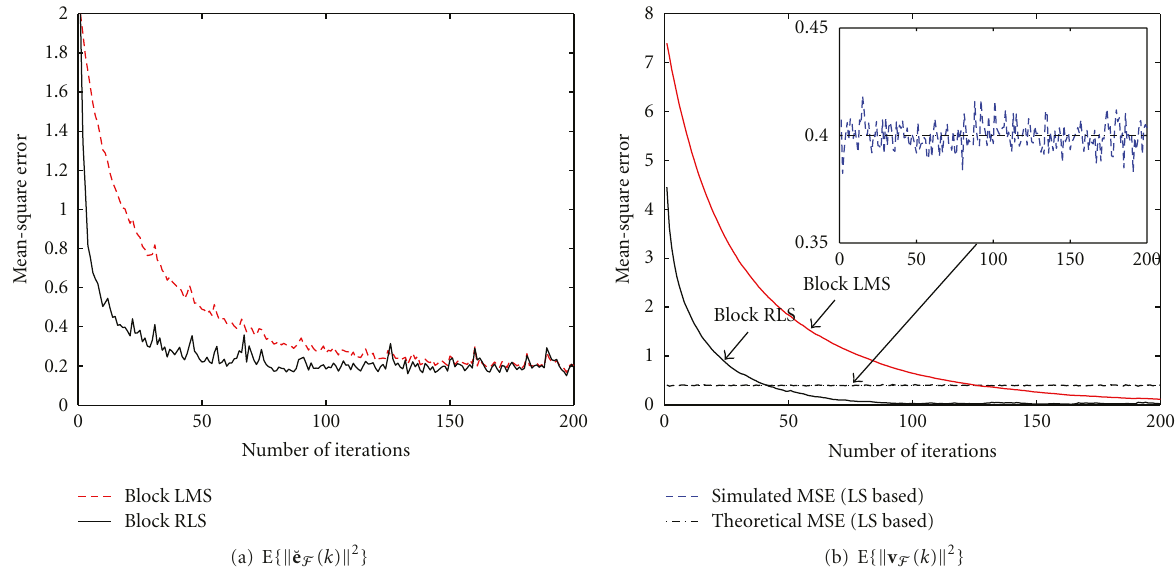
Figure 7: Learning curves of the block-wise LMS and RLS algorithmsfor the mean-square error E {(cid:10) ˘ e F ( k ) (cid:10) 2 } and E {(cid:10) v F ( k ) (cid:10) 2 } . f d T = 10 − 4 . Block RLS: λ = 0 . 8; block LMS: μ = 0 .